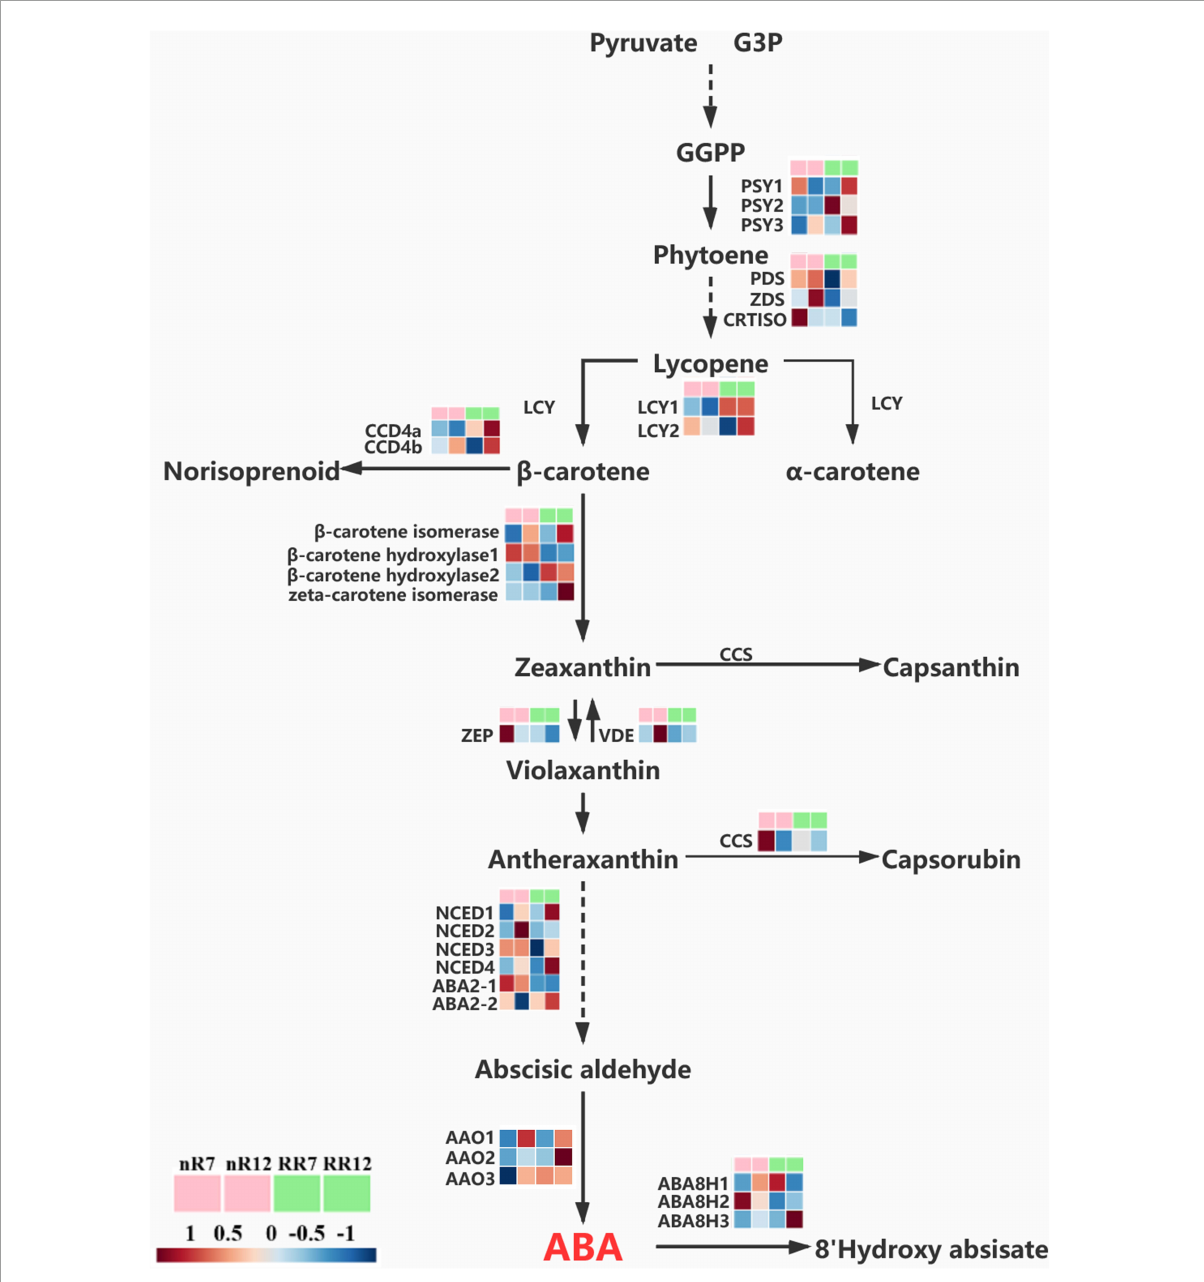
FIGURE9 Relative expression levels of genes in ABA biosynthesis and metabolism pathway. The expression levels of a total of 26 genes under different cultivation modes (nR and RR) and at different developmental stages (70 DAP and 125 DAP) are shown in heat maps, with red representing up-regulation and blue representing